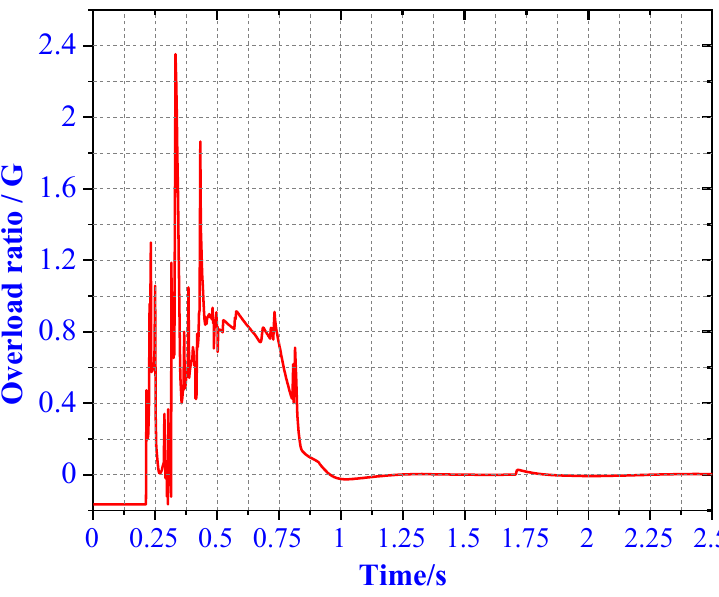
Figure 21. Overload rate of 1-2-1 type landing.